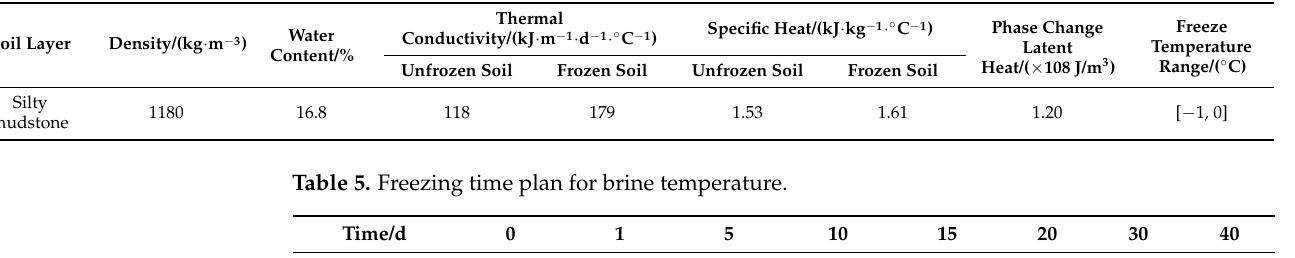
Figure 4. Mesh size and geometric size of the numerical model. ( a ) mesh and geometric size of the model; ( b ) distribution of freeze pipes. Table 4 shows the material parameters of the model obtained by the frozen soil tests [27 – 29]. In geometric modeling, the freezing pipe body is subtracted from the overall model by Boolean operation, leaving the surface of the freezing pipe as the thermal load boundary and the brine temperature as the boundary load. From the field-measured data, the process of brine cooling during the active freezing period is shown in Table 5. Accord- ing to the cooling plan, the freezing time step was 40 d, and the length of each step was 24 h. Table 4. Thermal parameters of soils.